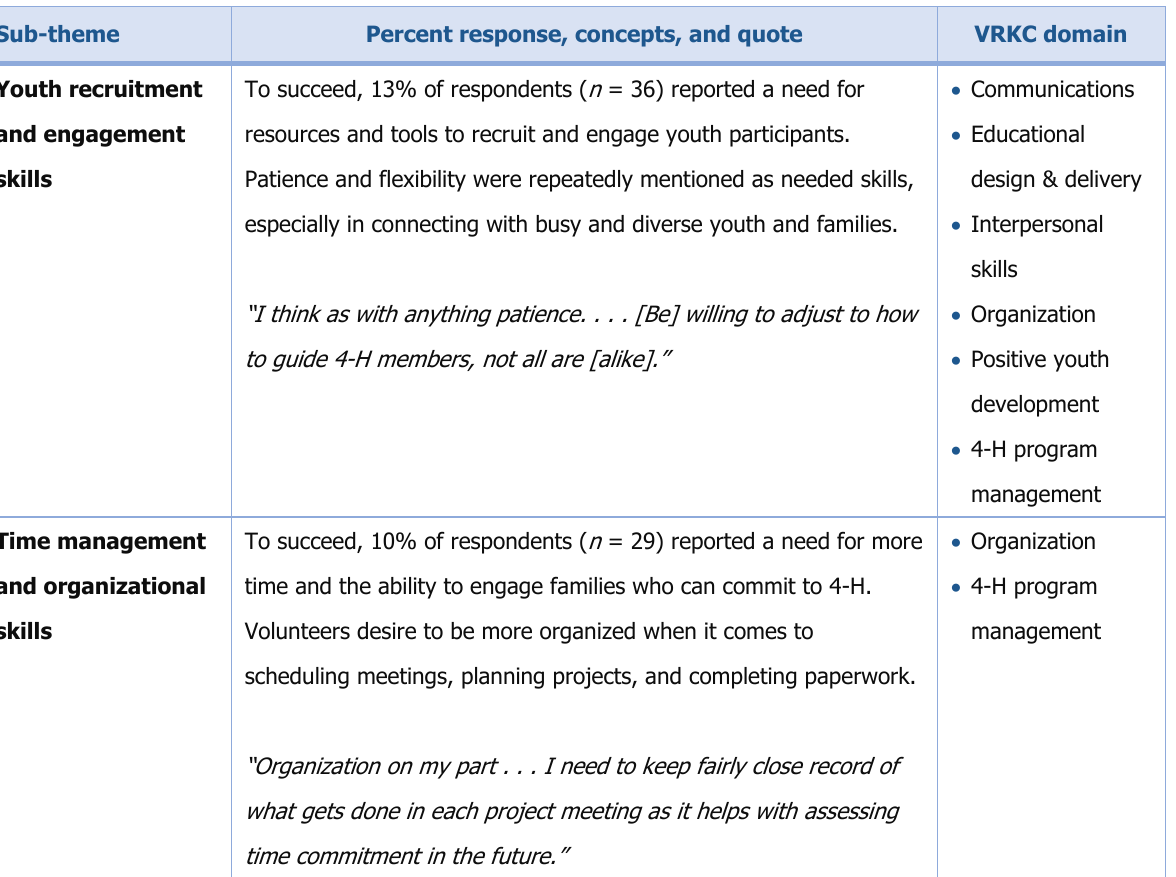
Table 11. “Needs for Success” Sub -Themes of the Youth and Family Engagement